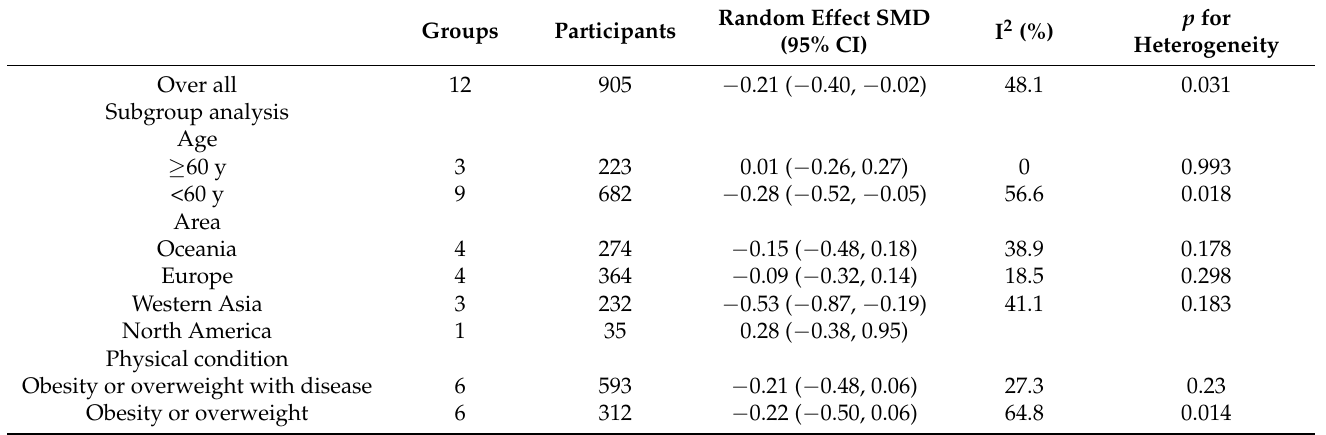
Figure 10. Forest plot of body weight changes after IF and CCR interventions based on fasting days. ( a ) Normal intermittent fasting (calorie restriction is usually two days per week). ( b ) Modified alternate-day fasting (a very low-calorie diet (75% energy restriction) during the three fast days). We carried out other subgroup analyses classified by age ( ≥ 60 y, <60 y), area (Oceania, Europe, Western Asia, North America), and physical condition (obesity or overweight, obesity or overweight with disease) (Table 4). No statistical significance was found for these factors. Table 4. Subgroups analyses of comparison of IF and CCR based on body weight